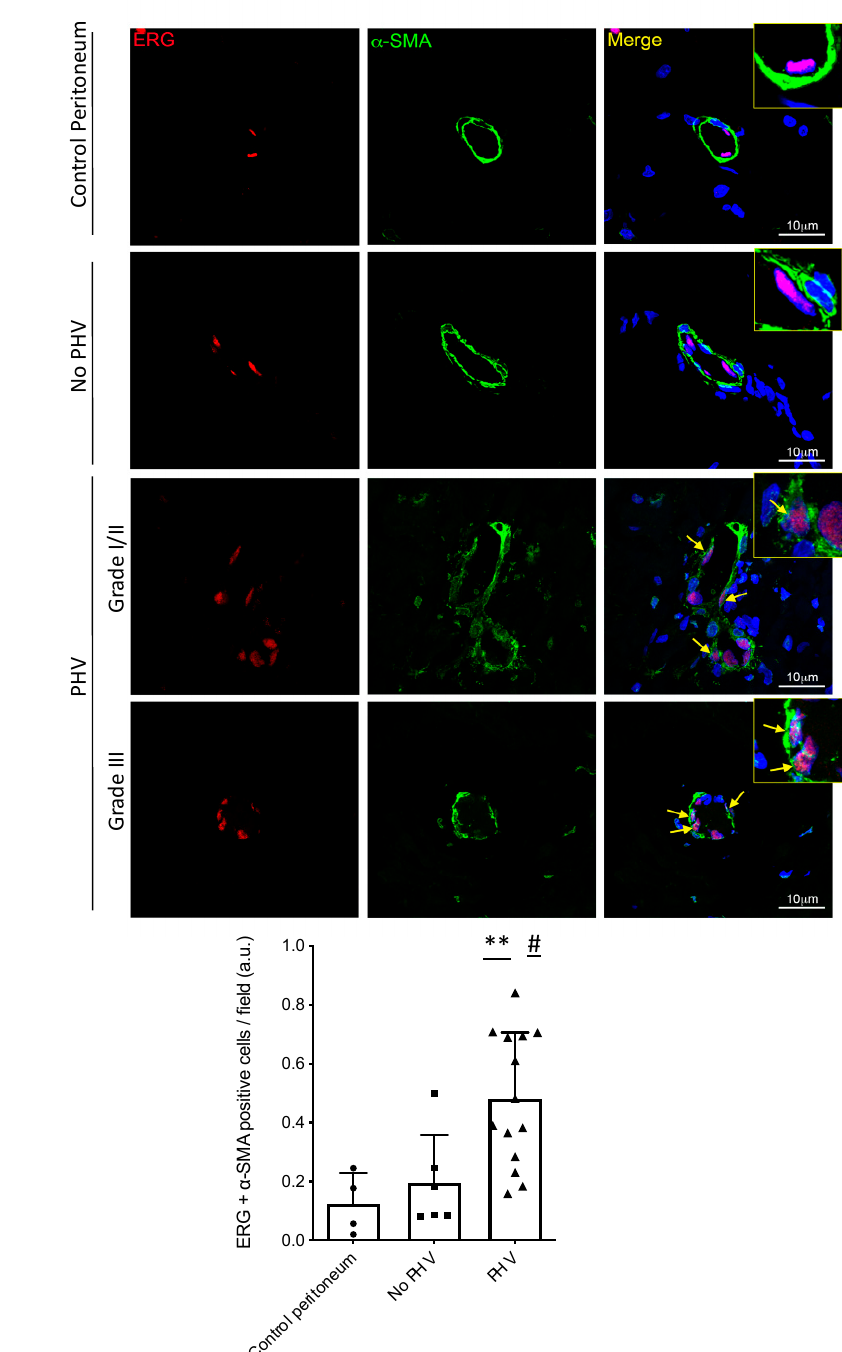
Figure 5. Detection of endothelial-to-mesenchymal transition in biopsies showing PHV. ( A ) Dual immunofluorescence staining representative pictures for ERG (endothelial marker) (red) and α -SMA (myofibroblast marker) (green) in a peritoneal capillary from a control sample, a PD-treated patient without PHV and patients presenting PHV at different degrees. Arrows point to double positive (ERG + α -SMA) endothelial cells indicating EndMT. Of note, perivascular smooth muscle cells are strongly marked for α -SMA in a normal vessel and in a PD patient without PHV. Perivascular smooth muscle cells seem to disappear in high-grade PHV biopsies. Insets show higher magnification of the delimited areas. ( B ) Double positive (ERG + α -SMA) endothelial cells were quantified. Graphic represents individual data points and the mean ± SEM. ** p < 0.01 vs. control group; # < 0.05 vs. No PHV